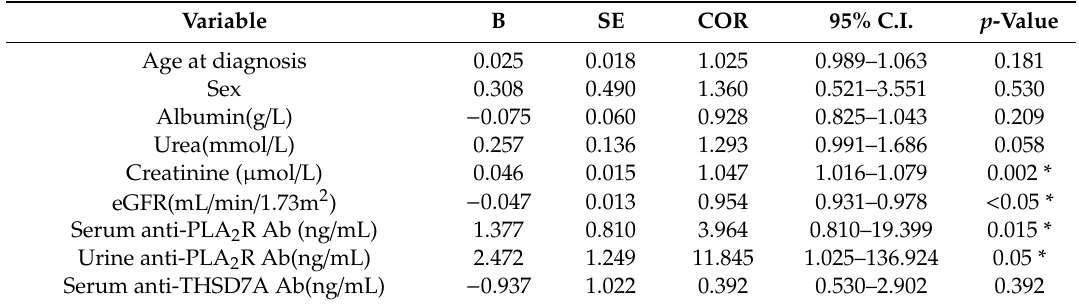
Table 6. Simple logistic regression for the prognostic outcome of primary MGN using UPCr Index (Remission). Variable B SE